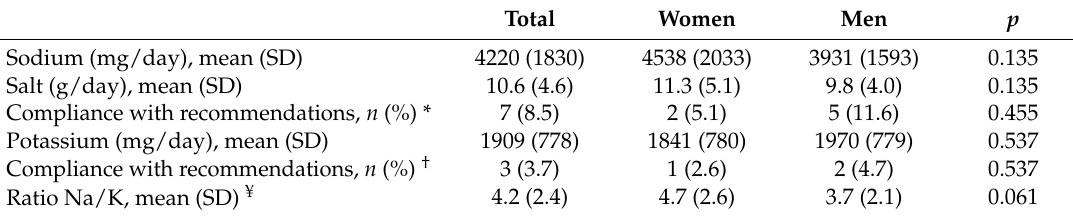
Table 3. Urinary data on sodium and potassium excretion, overall and by sex.